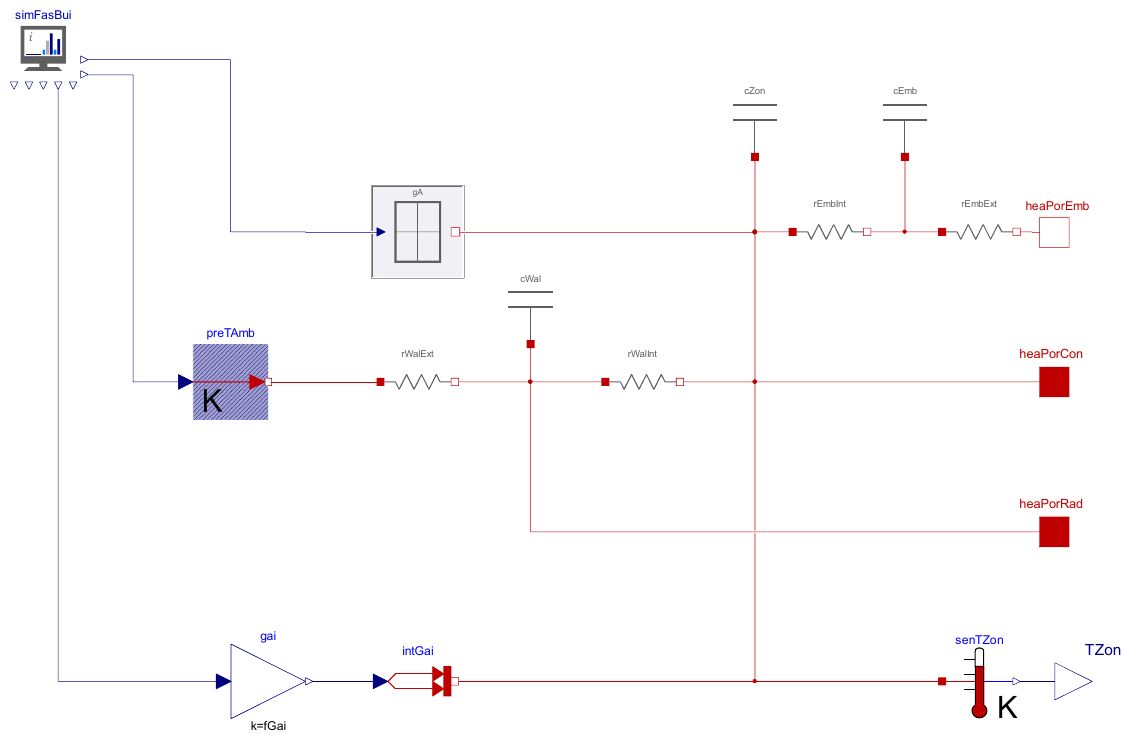
Figure A2. Grey-box model of the building envelope of the Vliet building test